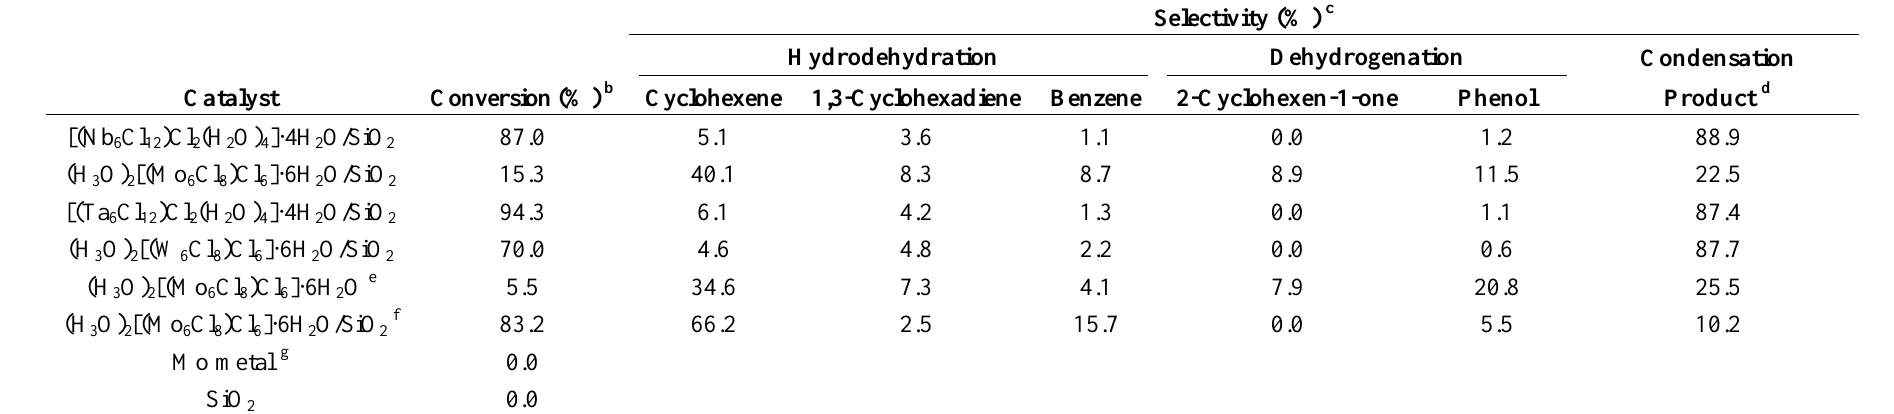
Table 3. Hydrodehydration, dehydrogenation, and condensation of cyclohexanone over halide clusters a